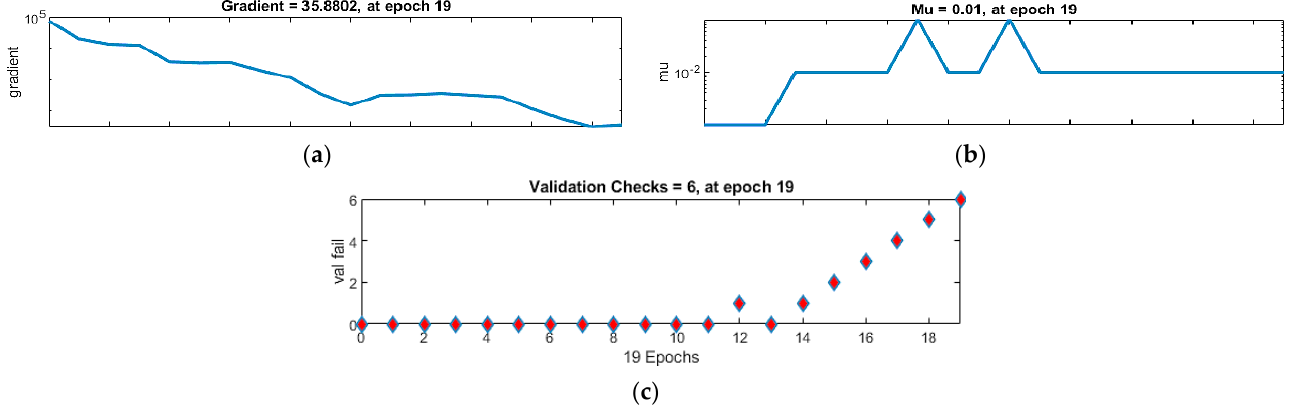
Figure 12. Neural network training state. ( a ) Gradient graph at epoch 19; ( b ) Mu graph at epoch 19; ( c ) Validation checks at epoch 19.